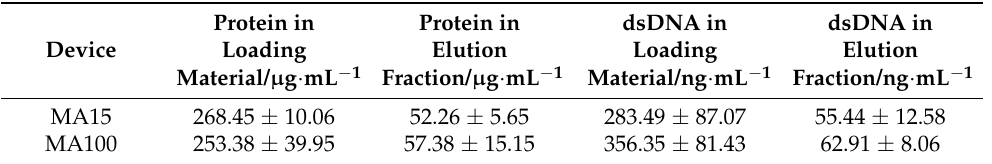
Table 2. Total protein and dsDNA concentration in loading material and elution fractions for SXC chromatography with the MA15 or MA100